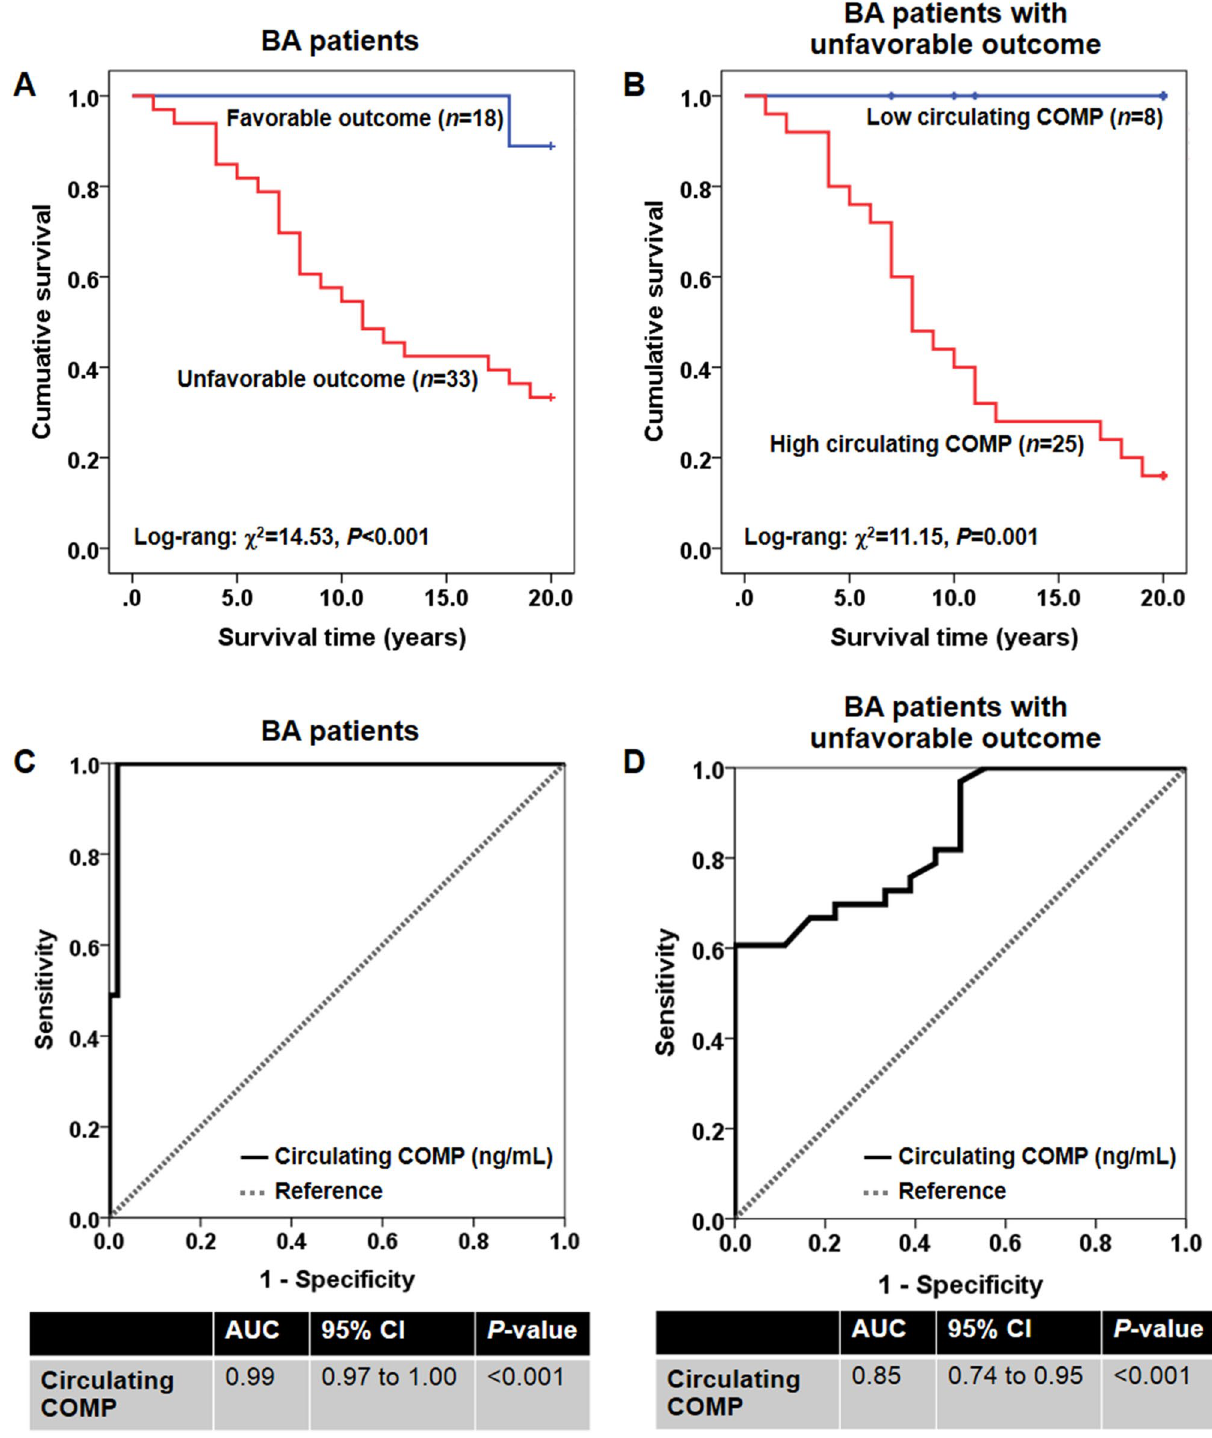
Figure 2. Kaplan–Meier survival curve of post-operative BA patients and receiver operating characteristic curve demonstrating diagnostic value of circulating COMP in BA patients. ( A ) Comparing survival curves between BA patients with favorable and unfavorable outcomes. ( B ) Comparing survival curves between low and high circulating COMP levels in BA patients with unfavorable outcome. ( C ) Possibility of circulating COMP as a biomarker for distinguishing BA patients from healthy controls. ( D ) Possibility of circulating COMP as a biomarker for discriminating BA patients with unfavorable outcome from favorable outcome following